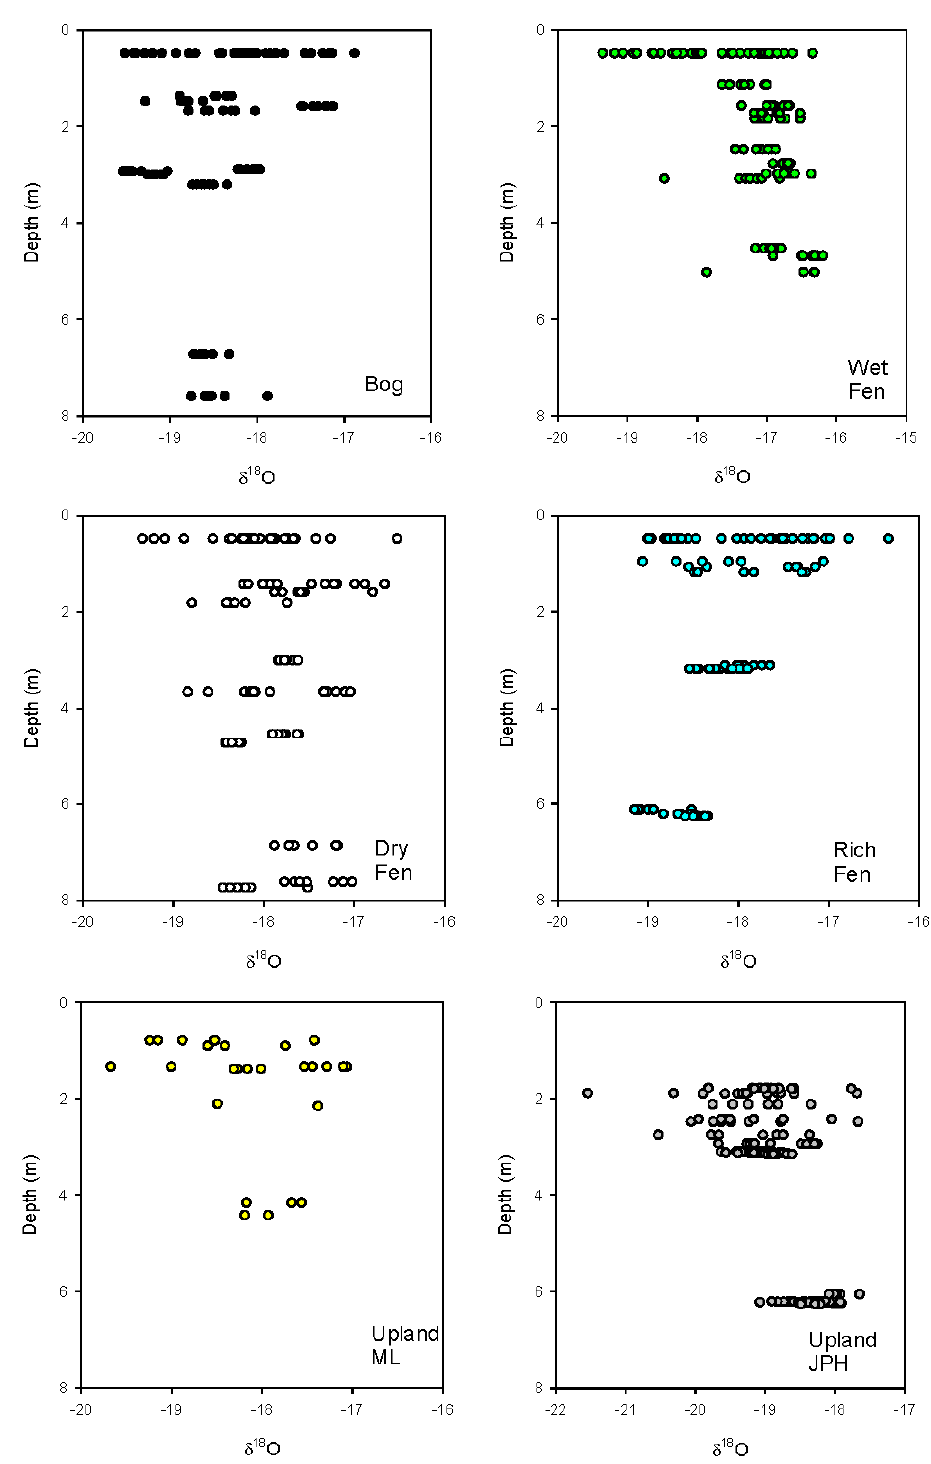
Figure 6. Depth-wise variations in δ 18 O in various terrain units: bog, wet fen, and dry fen (ML), rich fen (JPH), upland (ML), and upland (JPH). Seasonal variability is shown to be greater for near-surface soil water. Note that 10 highly-enriched water table well samples that were evidently sourced by brief summer precipitation events were not included.